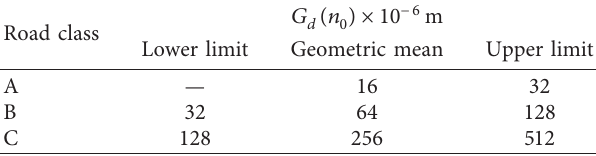
Table 3: ISO-8608 road roughness classification